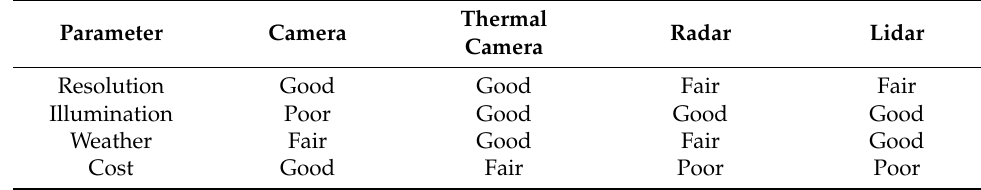
Table 6. Properties of sensors in AV perception systems